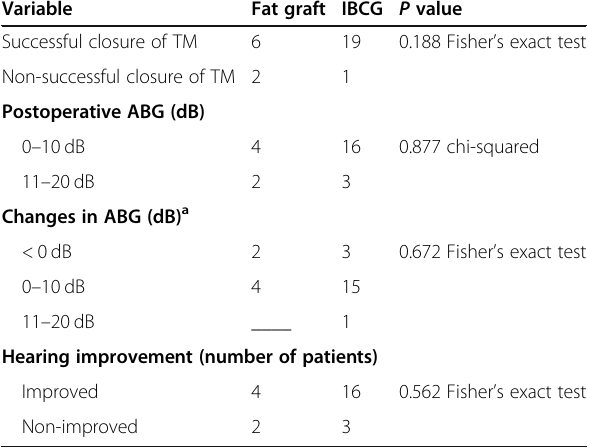
Table 2 Comparison of surgical and audiological outcomes